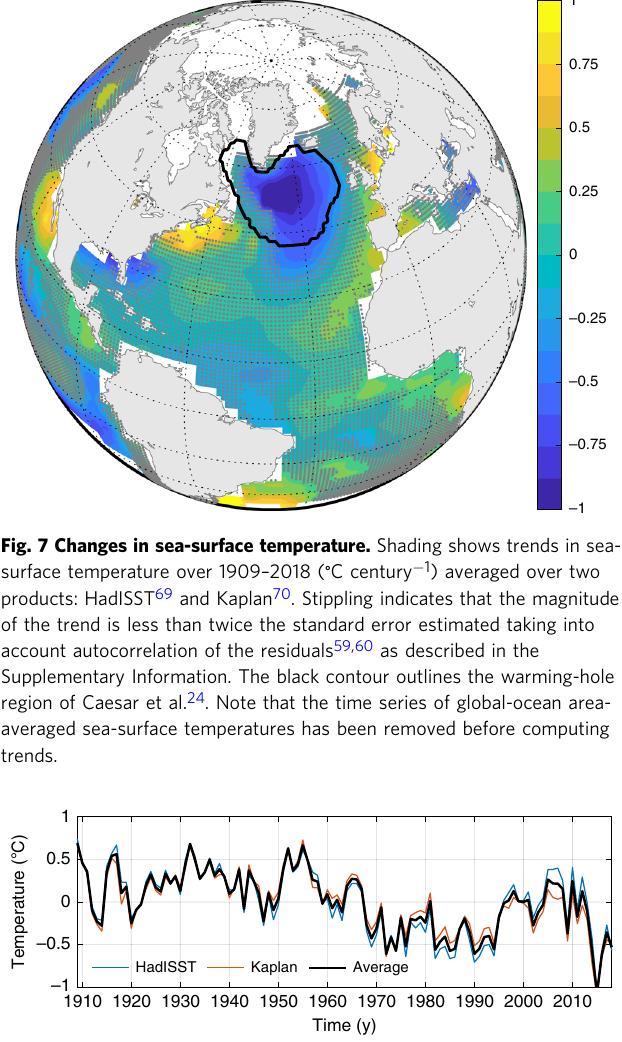
Fig. 8 Sea-surface-temperature changes over the warming hole. Time series of anomalous sea-surface temperature (°C; time-mean value removed) averaged over the warming-hole region of Caesar et al. 24 (see black contouring in Fig. 7) from HadISST 69 (blue), Kaplan 70 (orange), and the average between the two products (black). Note that the time series of global-ocean area-averaged sea-surface temperatures has been